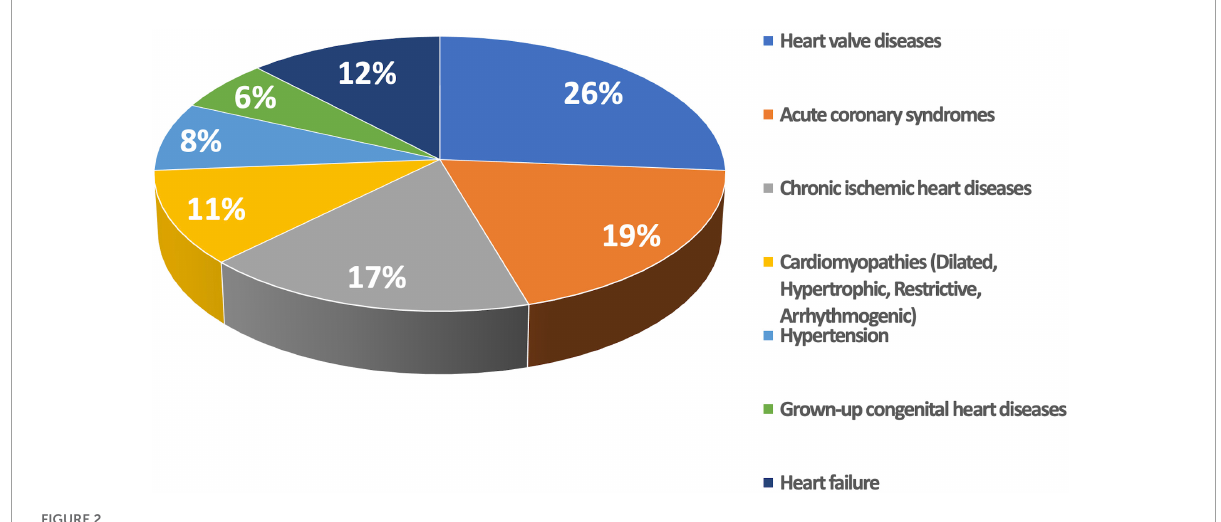
FIGURE2 Frequency of the different clinical indications for the echocardiographic